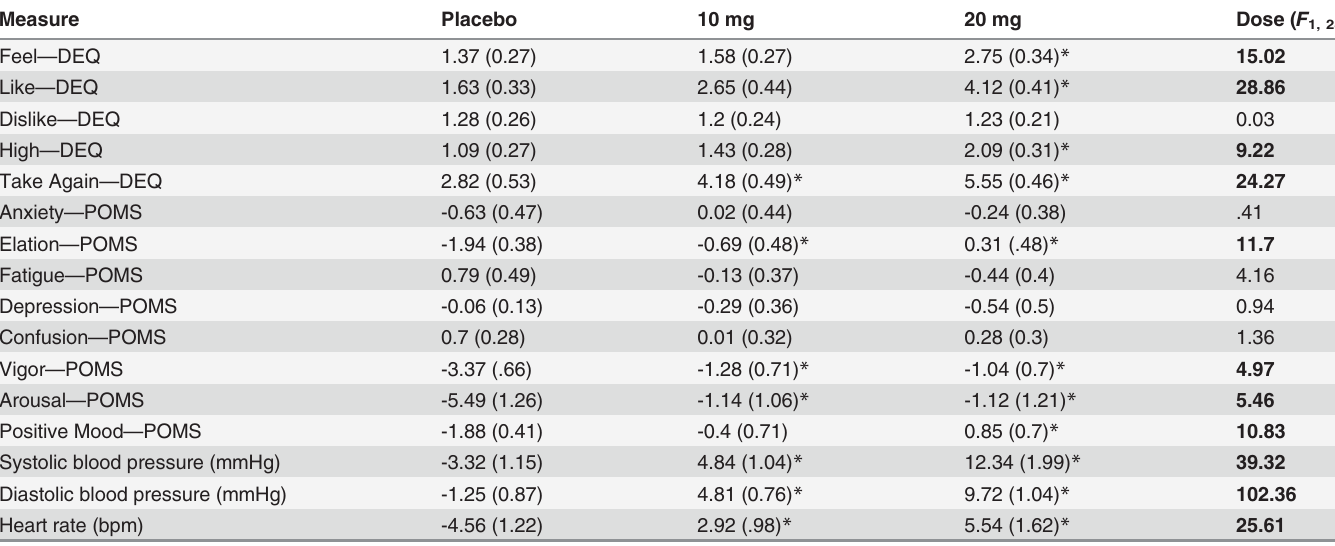
Table 4. Effects of METH on subjective and physiological measures in the encoding group ( n =